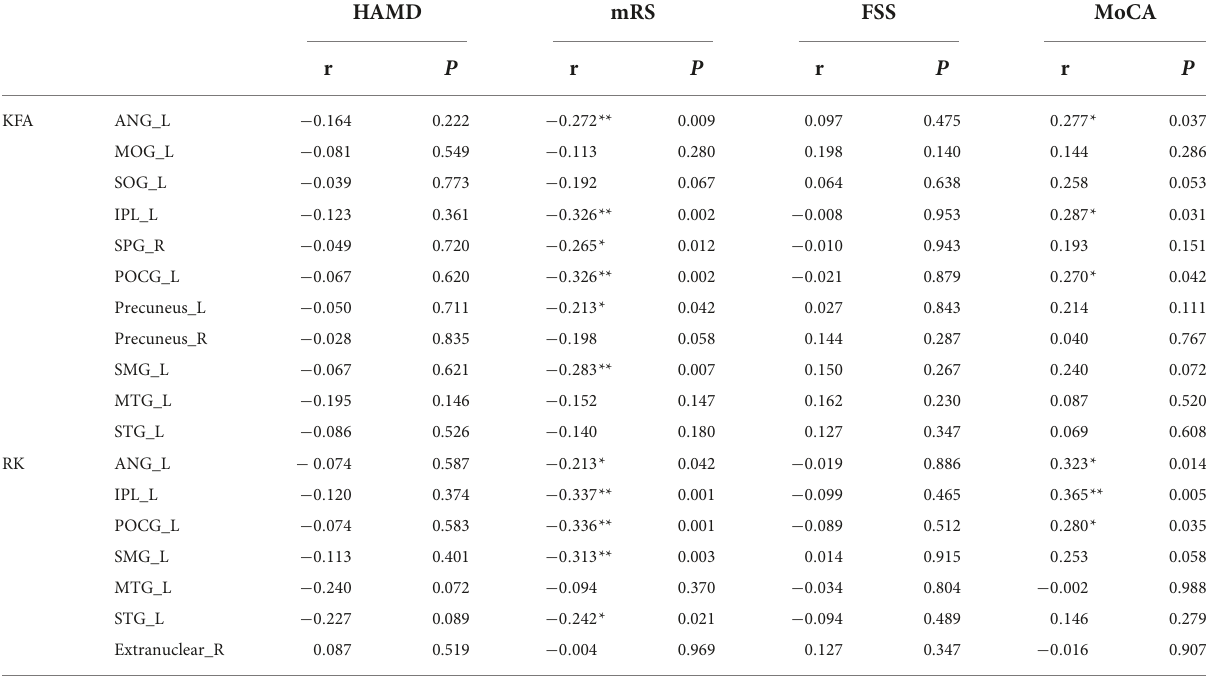
TABLE 3 Correlations between clinical scale scores and KFA and RK values in abnormal brain regions in patients with anti-NMDAR encephalitis. HAMD mRS FSS